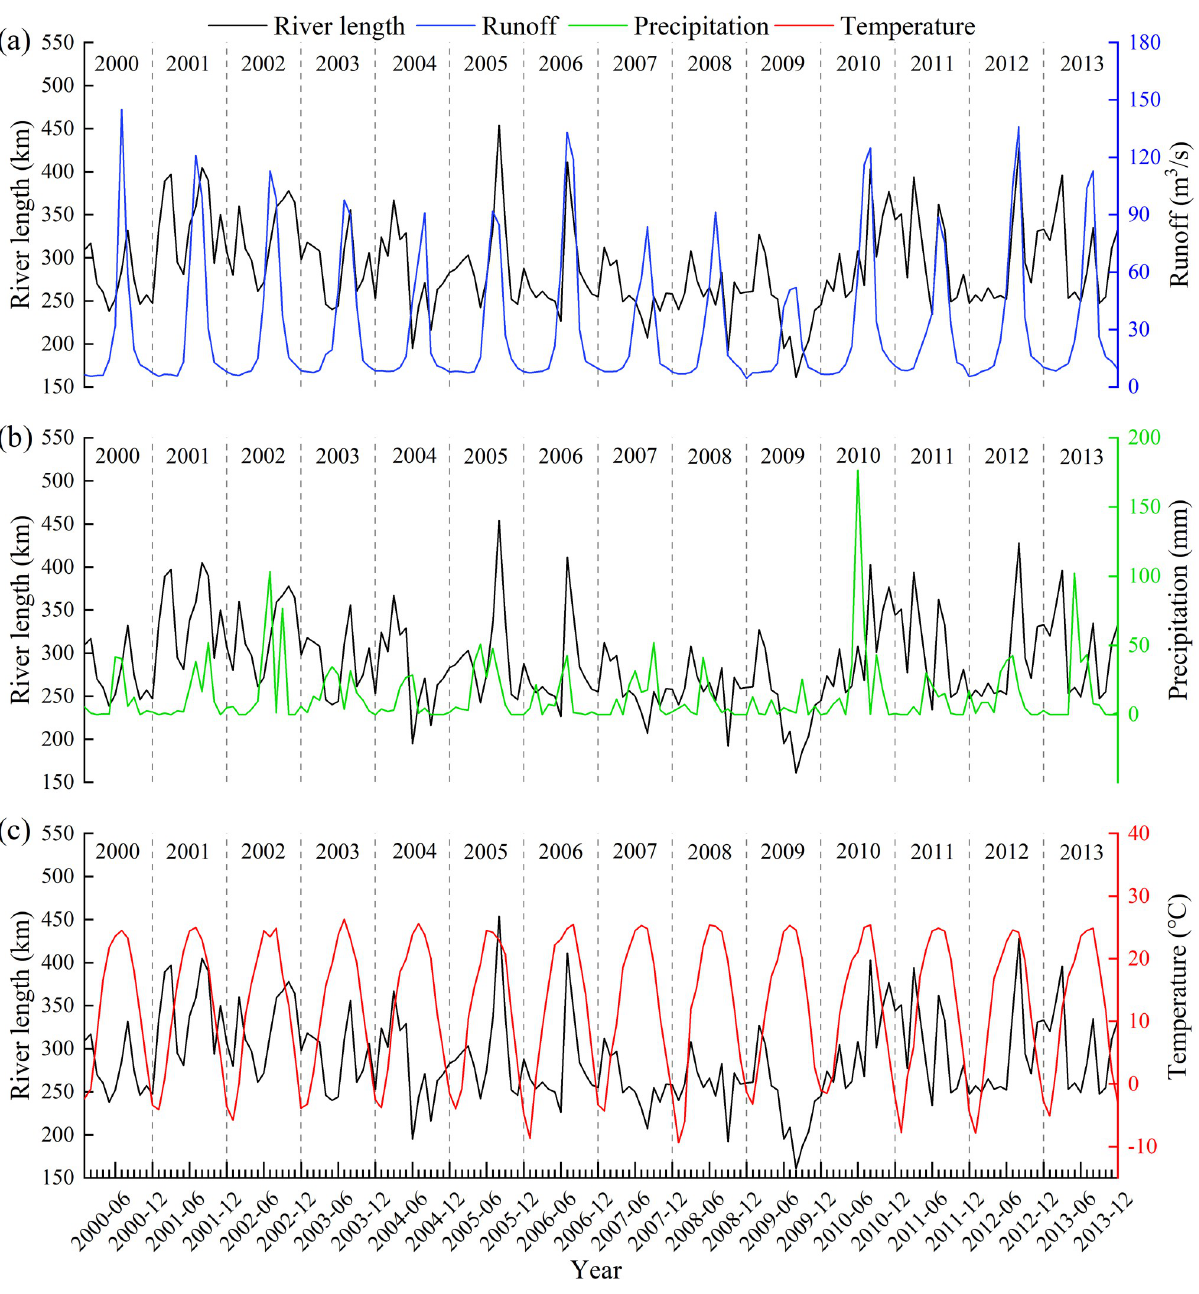
Fig 9. Observed changes between lower reach river length and hydro-meteorological data in the Keriya River Basin. (a), (b) and (c) represent the dynamic changes between lower reach river length and upper reach runoff, precipitation, and temperature from 2000 to 2013, respectively.